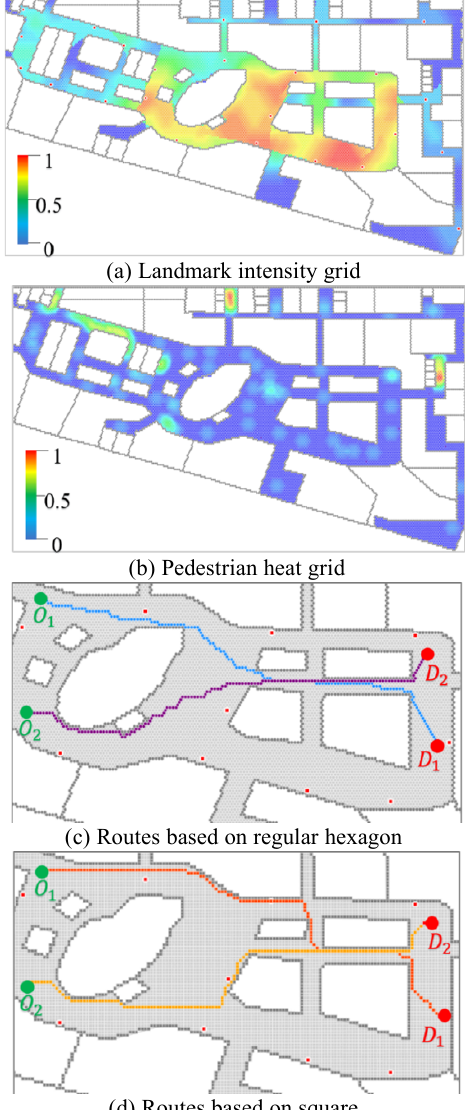
Figure 5. Landmark intensity, pedestrian heat grid, route planning results based on square and regular hexagon of